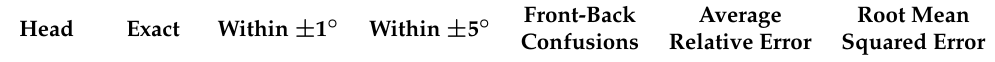
Table 3. Direction of arrival accuracy comparison for the direct sound and reflected components measured with the KEMAR and KU100 binaural dummy heads, for both the cascade-correlation neural network and the baseline